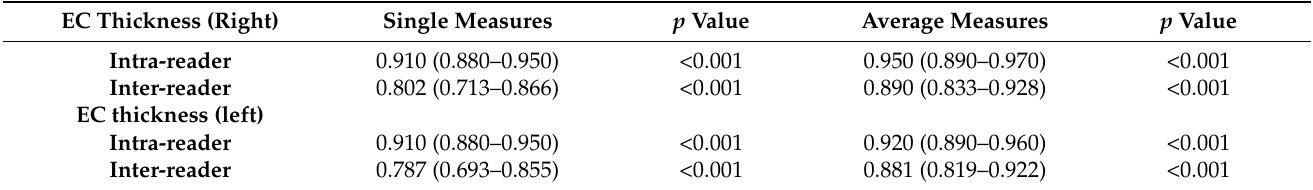
Table 2. Intra and inter-reader reliability; intraclass correlation coefficient (95% confidence